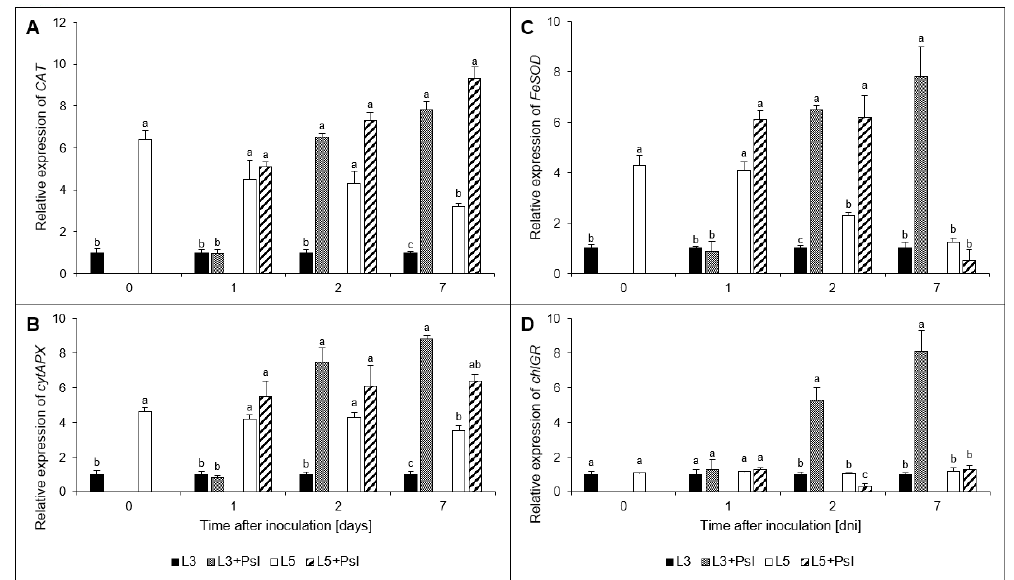
Figure 8. Relative expressions of antioxidant genes: ( A ) Catalase gene ( CAT ); (B ) cytosolic ascorbate peroxidase gene ( cytAPX ); ( C ) chloroplast superoxide dismutase isoform gene ( FeSOD ); ( D ) chloroplast glutathione reductase gene ( chlGR ) expressions. Values are means of four replicates (±SD). Different letters (a – c) indicate significant ( p ≤ 0.05 ) differences between experimental variants within a given time point.